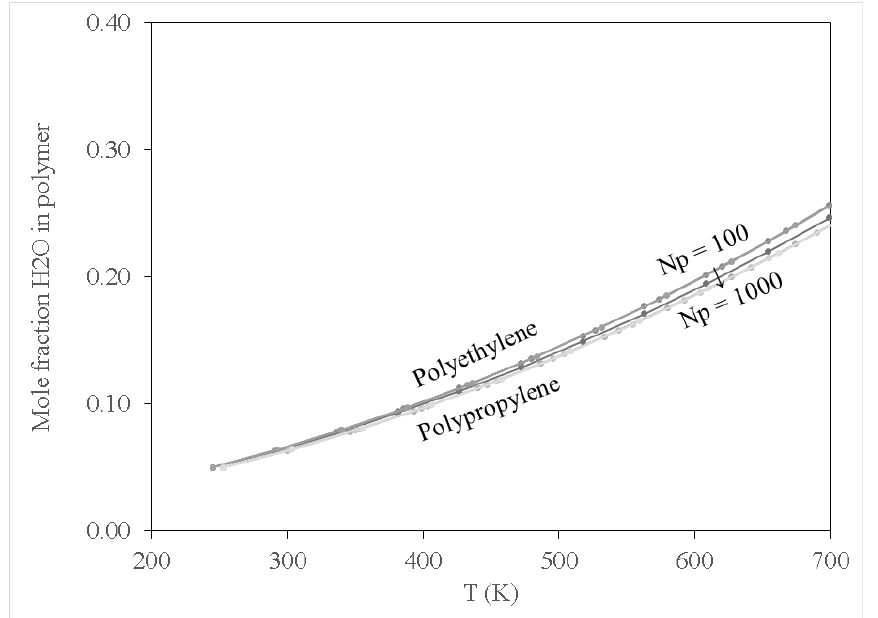
Figure 5. Effect of temperature on water (H 2 O) content of PP and PE with respect to the degree of polymerisation (Np).